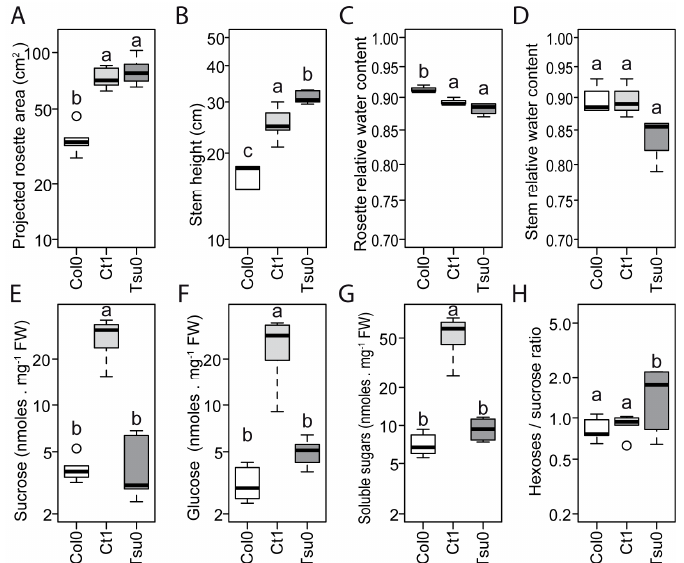
Figure 3. Natural variation in the size and sugar content of the Ctrl Arabidopsis plants. ( A – H ) The box and whisker plots represent the distribution of the biological replicates (see Figure 2 for details) with in ( A ) the projected rosette area ( n = 5–6), ( B ) stem height ( n > 9), ( C ) rosette relative water content ( n = 4), ( D ) stem relative water content ( n = 4), ( E ) sucrose content, ( F ) glucose content, ( G ) total soluble sugar content (i.e., sucrose, glucose, and fructose), and ( H ) and hexoses-to-sucrose ratio (( E – H ): n = 5–6). All of the data were obtained at 17 DAB, except for the rosette and stem relative water content that were measured at 16 DAB. Different letters indicate significant differences among the accessions determined using a one-way analysis of variance (ANOVA), combined with a Tukey’s comparison post-test ( p < 0.05).